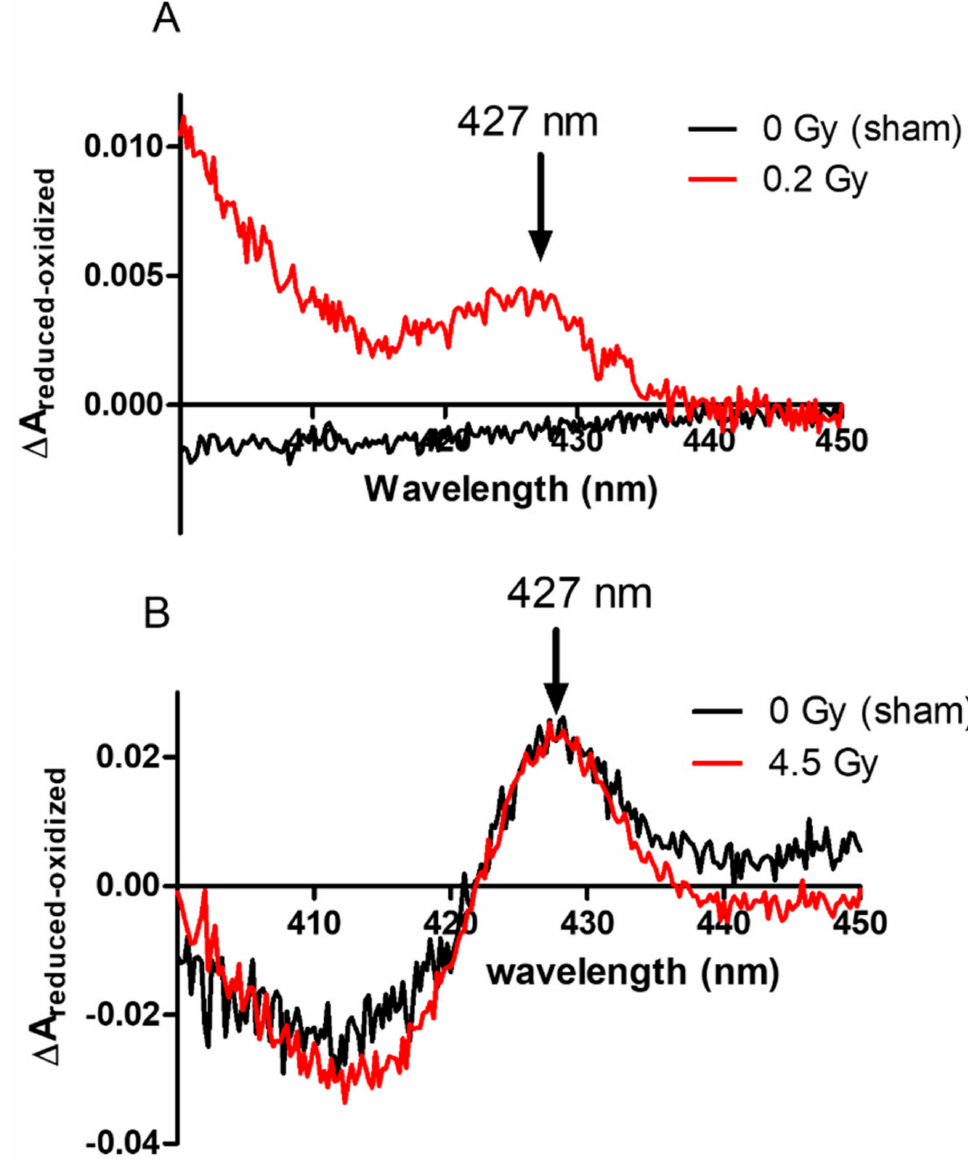
Figure 3. Dithionite reduced minus oxidized Soret band (427 nm) of membrane fractions purified ( A ) from irradiated (0.2 Gy) and non-irradiated PLB cells. ( B ) Irradiated neutrophil membrane fractions. The measured solution contained 100 µ L of membrane fractions from surviving cells, 2 fold diluted and solubilized in 1% Dodecylmaltoside (DDM) in a quartz cuvette. The reference cuvette contained a similar solution. The reduced form was obtained by adding 1 mg of sodium dithionite to the sample cuvette after taking the oxidized spectrum. Observations were made with 2 or more independent